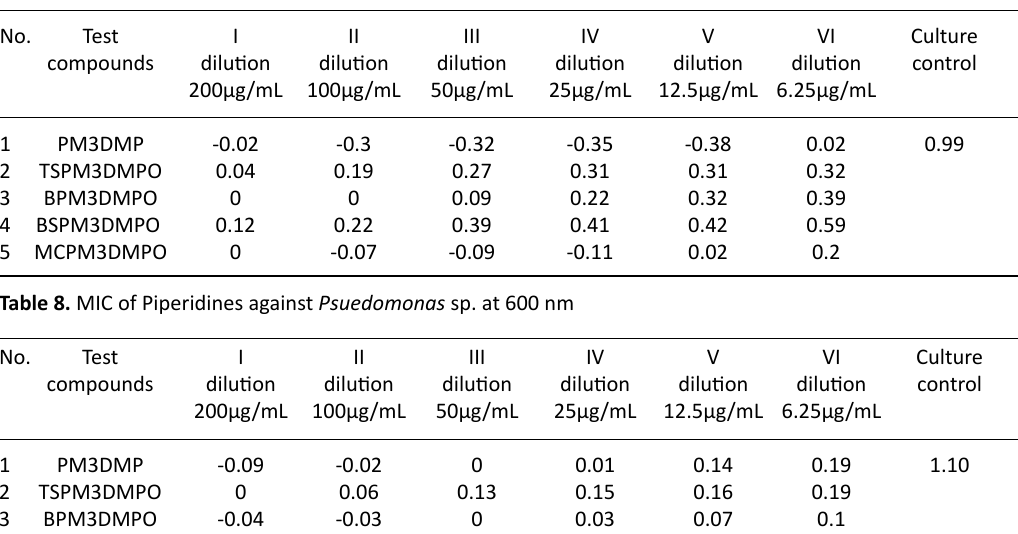
Table 7. MIC of Piperidines against Salmonella sp. at 600 nm No.